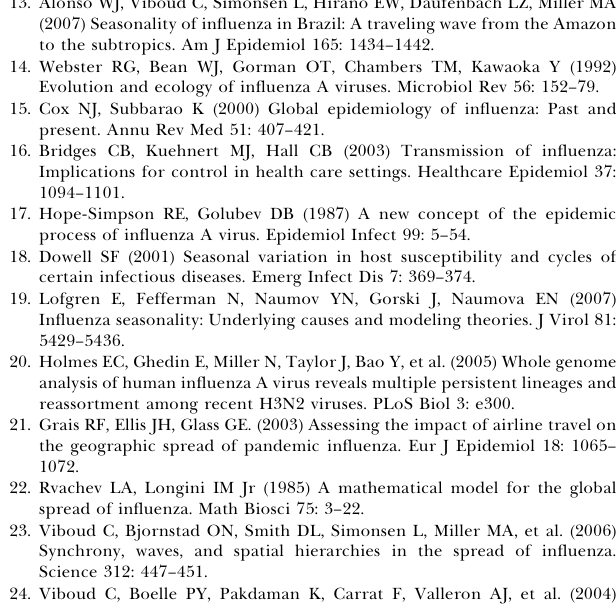
Color scheme, rooting, scale, and symbols are the same as those used in Figure S1. Figure S4. Phylogenetic Relationships of the NP Gene of A/H3N2 Influenza Viruses Sampled from New York State ( n ¼ 52), New Zealand ( n ¼ 51), and Australia ( n ¼ 45) from 1998–2005, Estimated Using ML Method Color scheme, rooting, scale, and symbols are the same as those used in Figure S1. Figure S5. Phylogenetic Relationships of the M1 Gene of A/H3N2 Influenza Viruses Sampled from New York State ( n ¼ 52), New Zealand ( n ¼ 51), and Australia ( n ¼ 45) from 1998–2005, Estimated Using ML Method Color scheme, rooting, scale, and symbols are the same as those used in Figure S1. Figure S6. Phylogenetic Relationships of the NS1 Gene of A/H3N2 Influenza Viruses Sampled from New York State ( n ¼ 52), New Zealand ( n ¼ 51), and Australia ( n ¼ 45) from 1998–2005, Estimated Using ML Method Color scheme, rooting, scale, and symbols are the same as those used in Figure S1. Table S1. Complete Genome Sequences of A/H3N2 Influenza Viruses Sampled from Australia, New Zealand, and New York State Used in This Study Found at doi:10.1371/journal.ppat.0030131.st001 (535 KB